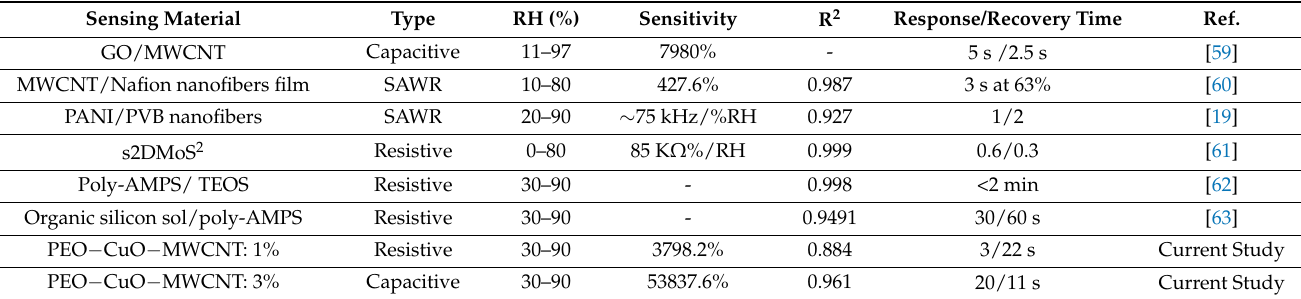
Table 1. A comparison of the resistive and capacitive response to